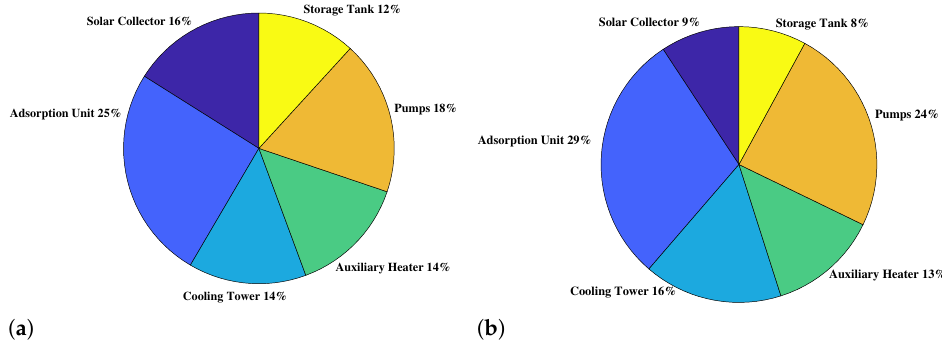
Figure 4. Cost percentage for: ( a ) base case, ( b ) optimum case. Table 5. List of simulation parameters with related values.